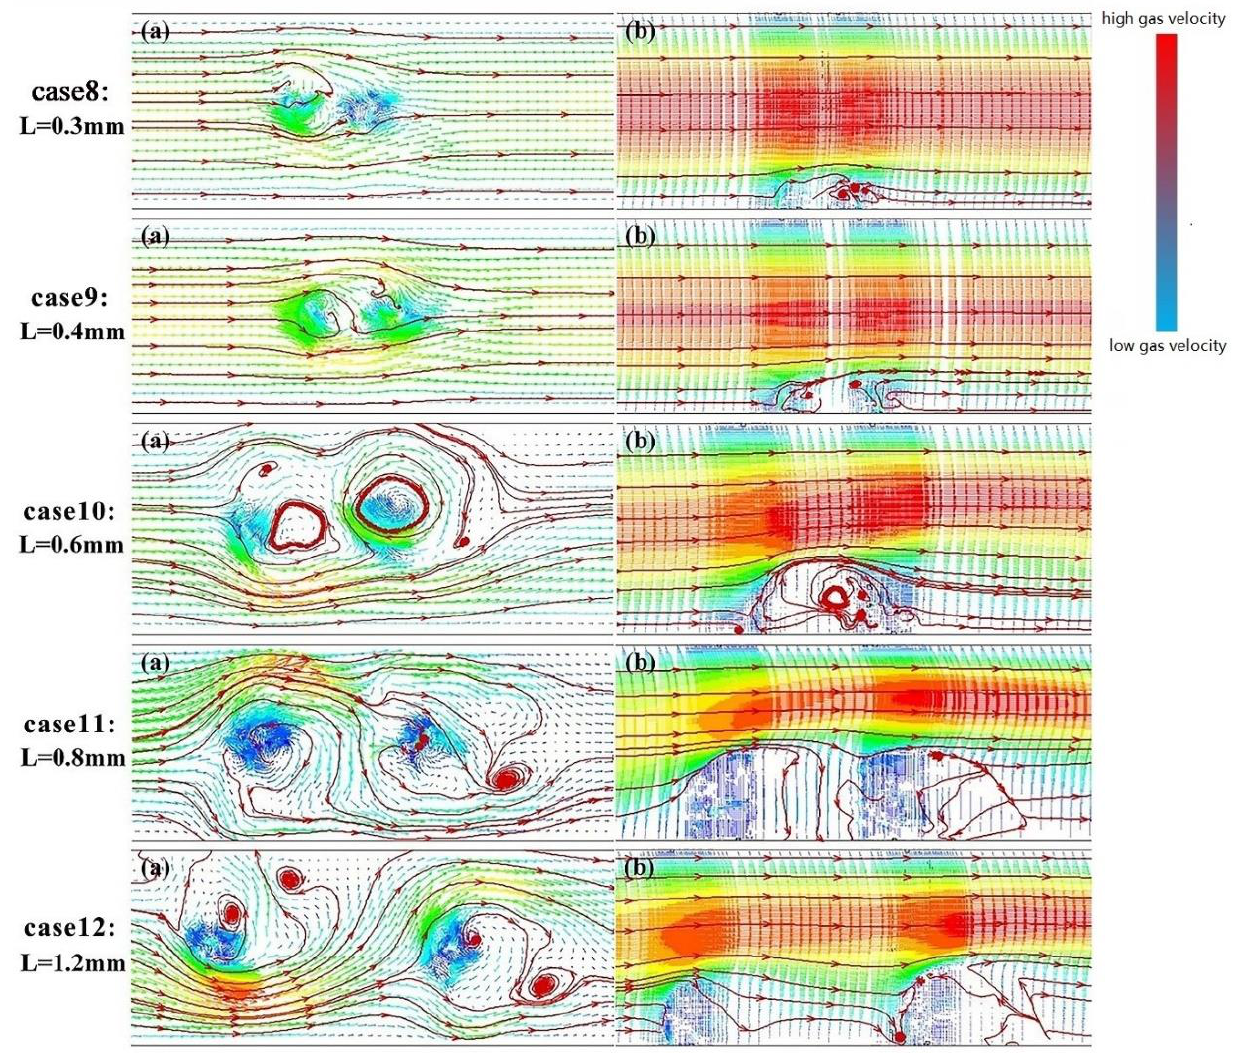
Figure 9. The flow lines and velocity vectors of the air around the droplets (( a ) X-Z plane, ( b ) X-Y plane). In Figure 9, case 8 and case 9 are gas velocity flow fields when the two droplets start to merge. As can be seen from this figure, the droplet volume is small at this time, but it can still obstruct the airflow and cause the phenomenon of bypass flow, creating a void space downstream of the merged droplet. Due to the small pore distance at this time, the downstream liquid droplet is just in the void space of the upstream liquid droplet.